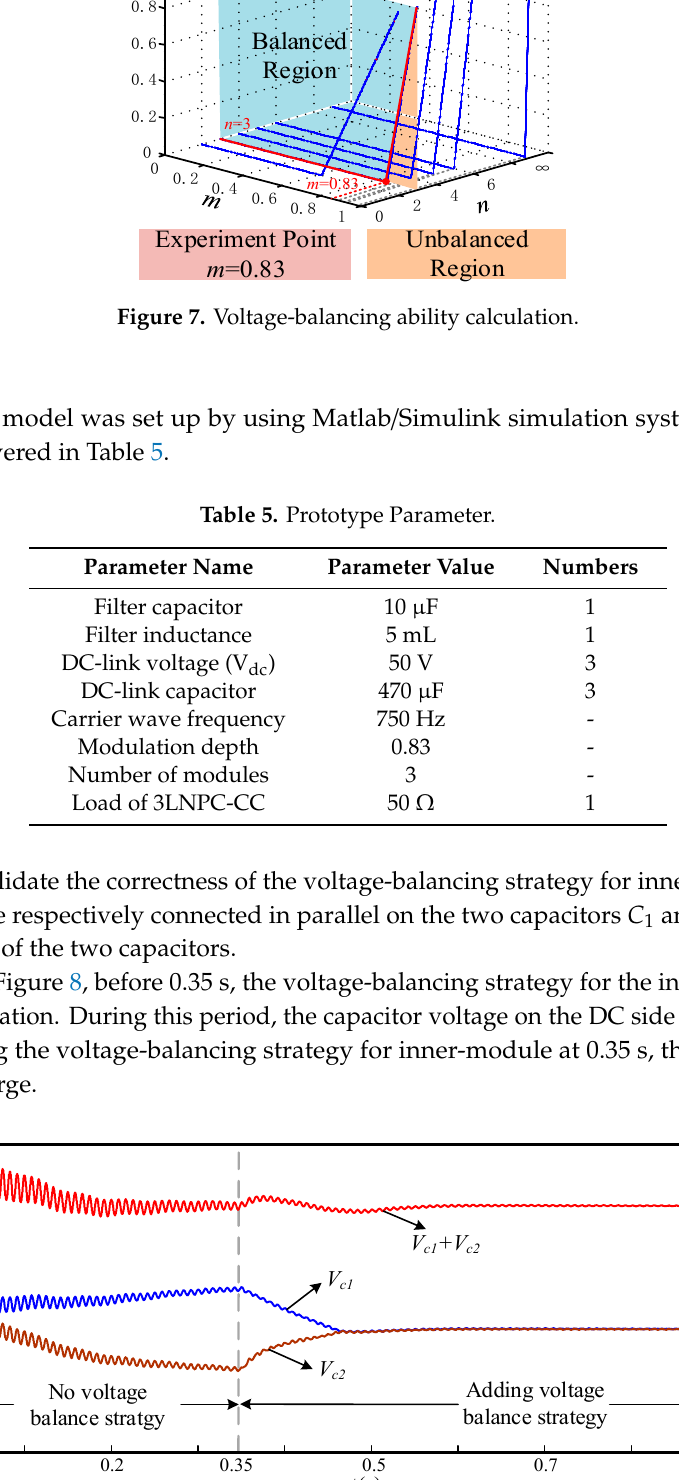
Figure 8. The waveform of capacitors’ voltage on DC-link .